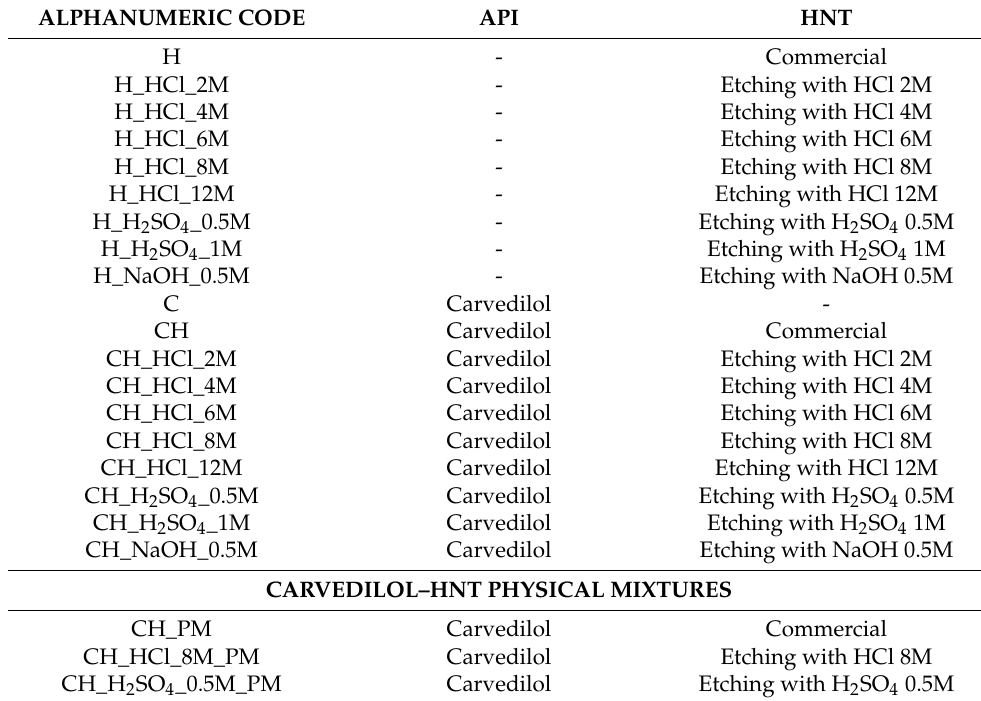
Table 1. List and names of the investigated